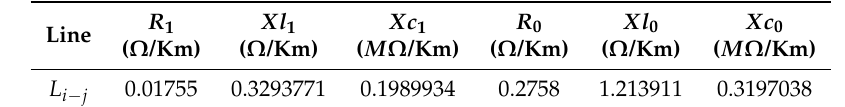
Table A5. Transmission line parameters.